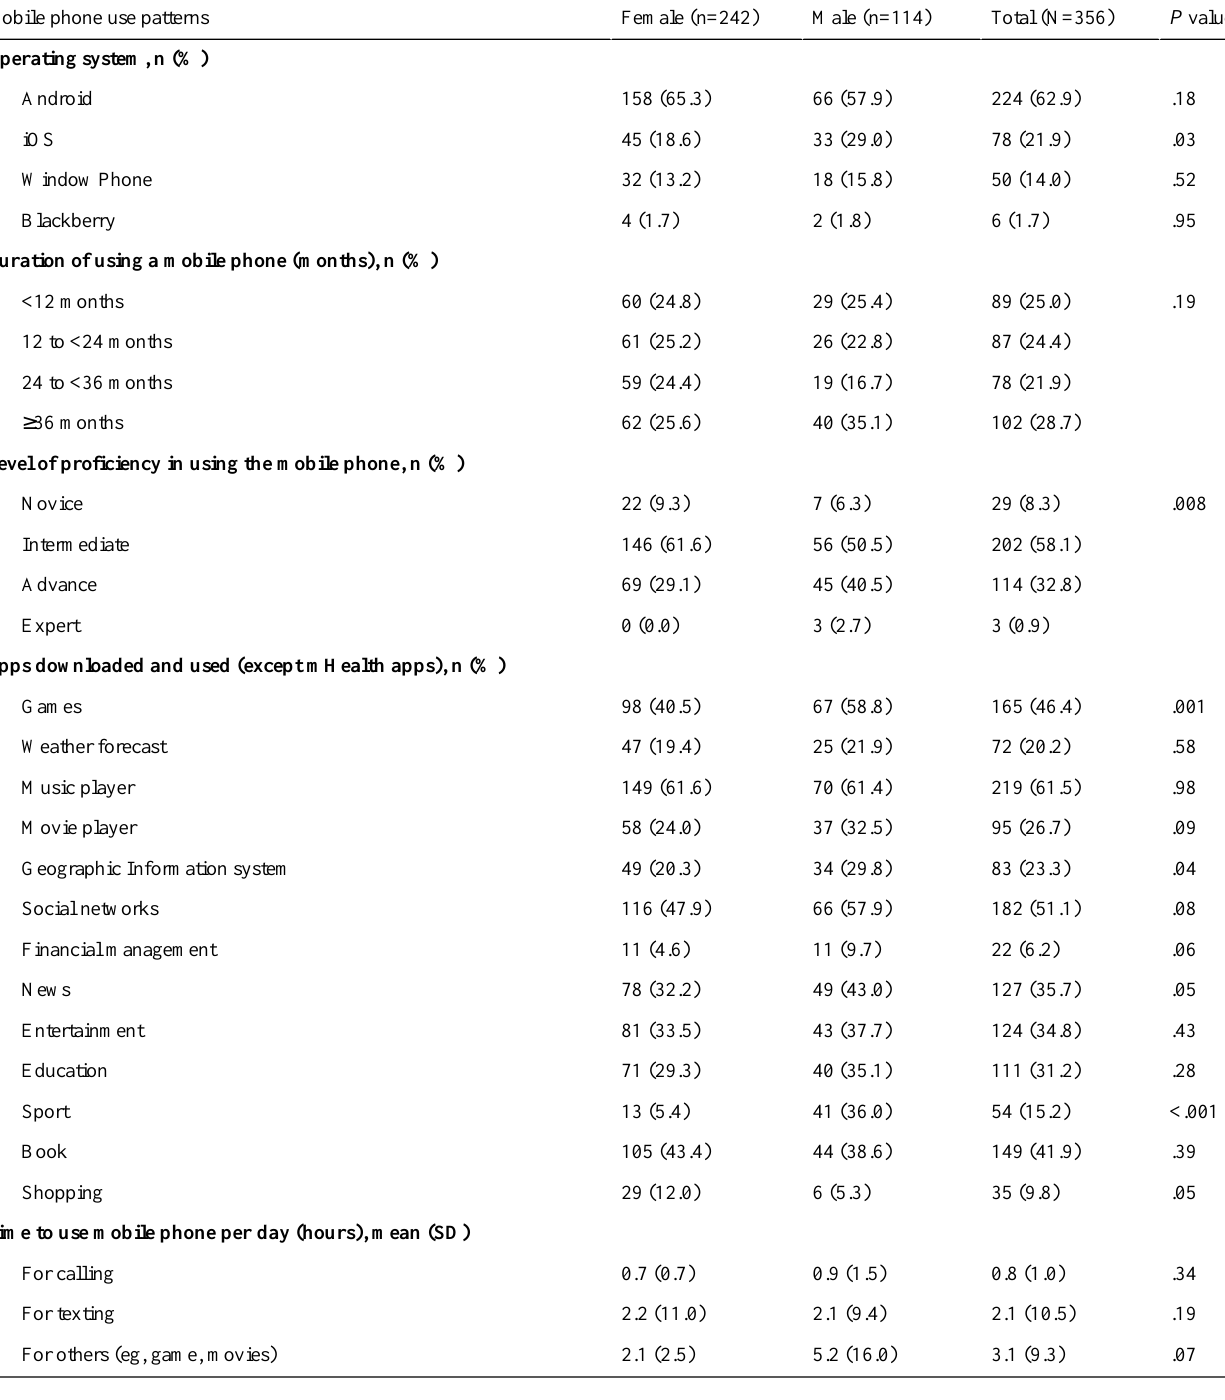
Table 2. Mobile phone use patterns among